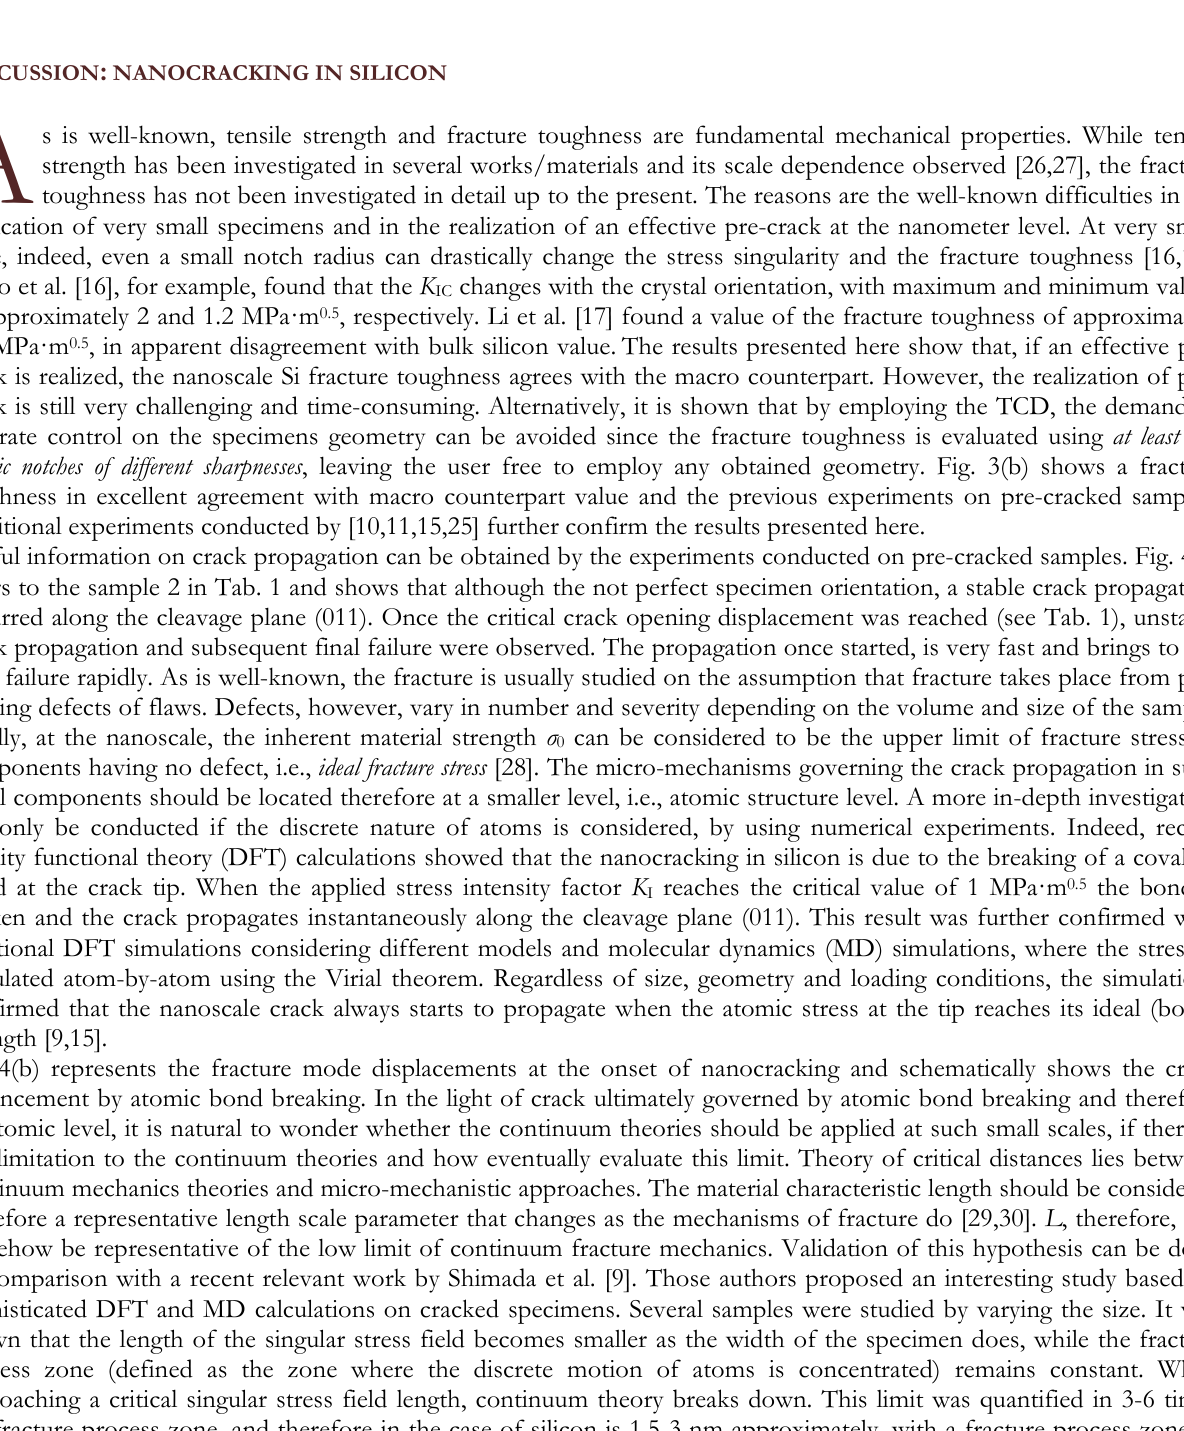
Table 2: Geometry of the notches, deflection at failure δ f and load at failure P f